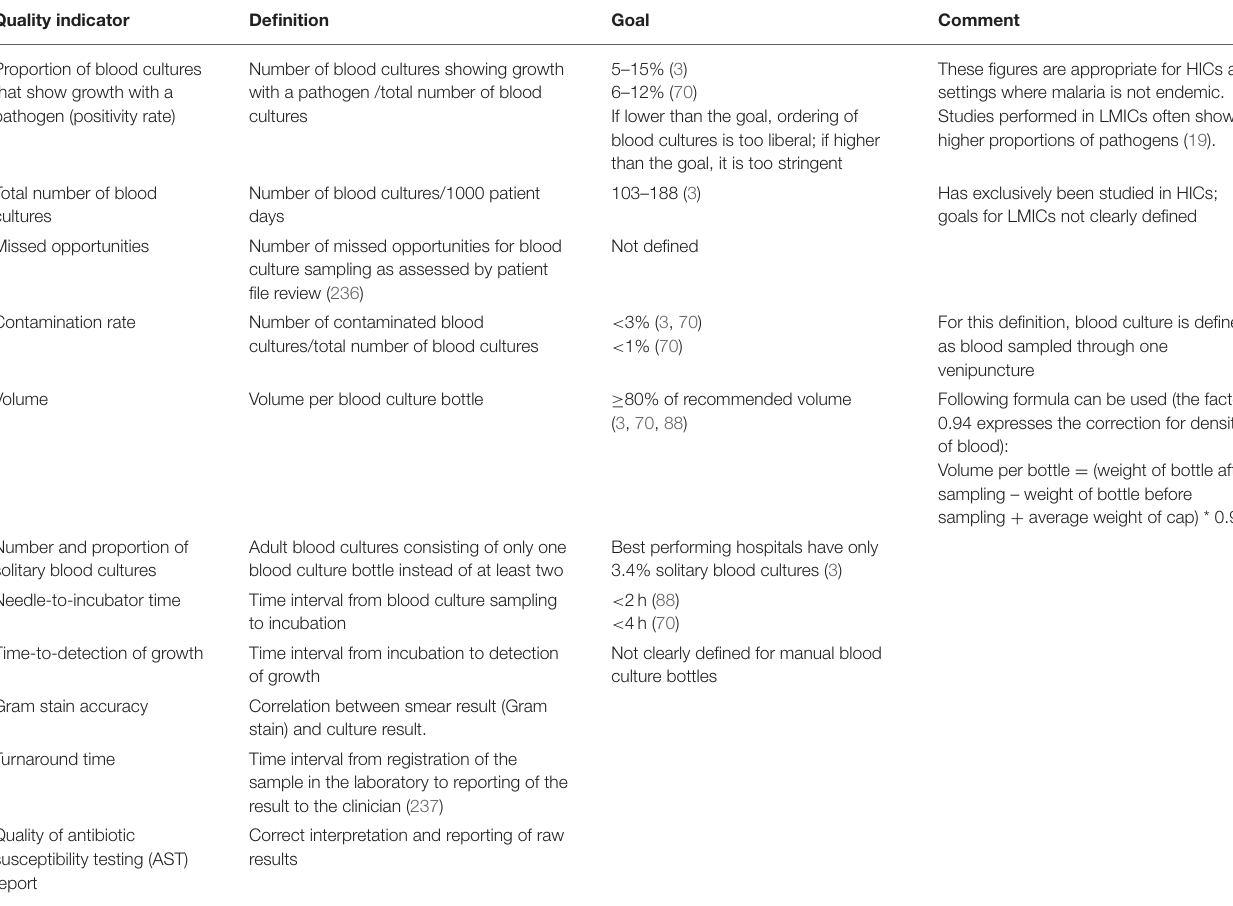
TABLE 6 | Quality indicators for monitoring of blood cultures—they can be used for validation as well as for monitoring purposes. Quality